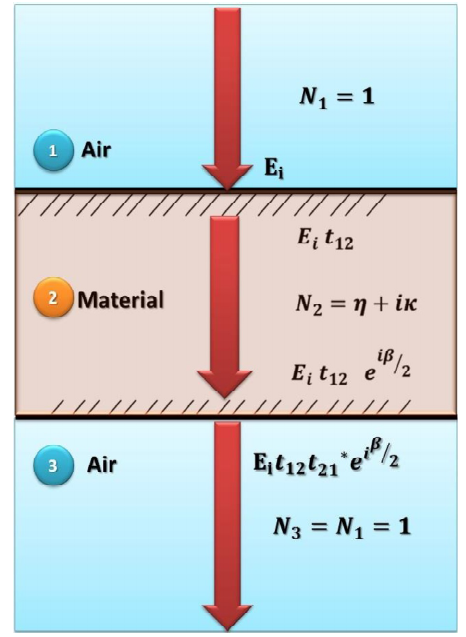
Fig. 3. Schematic of the light transmittance on a material and parameters to consider